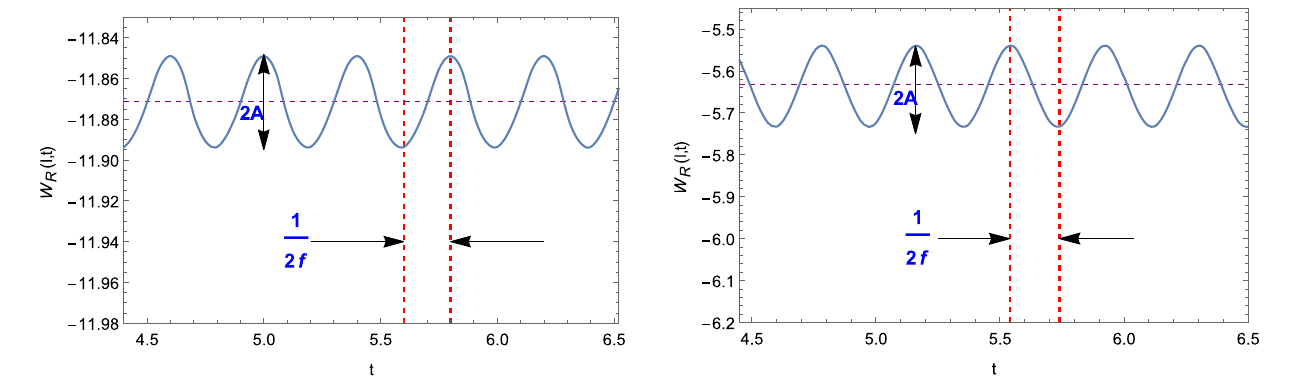
Fig. 5 The expectation value of the Wilson loop in terms of boundary time for ν = 4, k = 0 . 3 and l = 1. The final temperature for the graph left (right) are 0.159 (0.796) and oscillation frequency is 0.19 for both